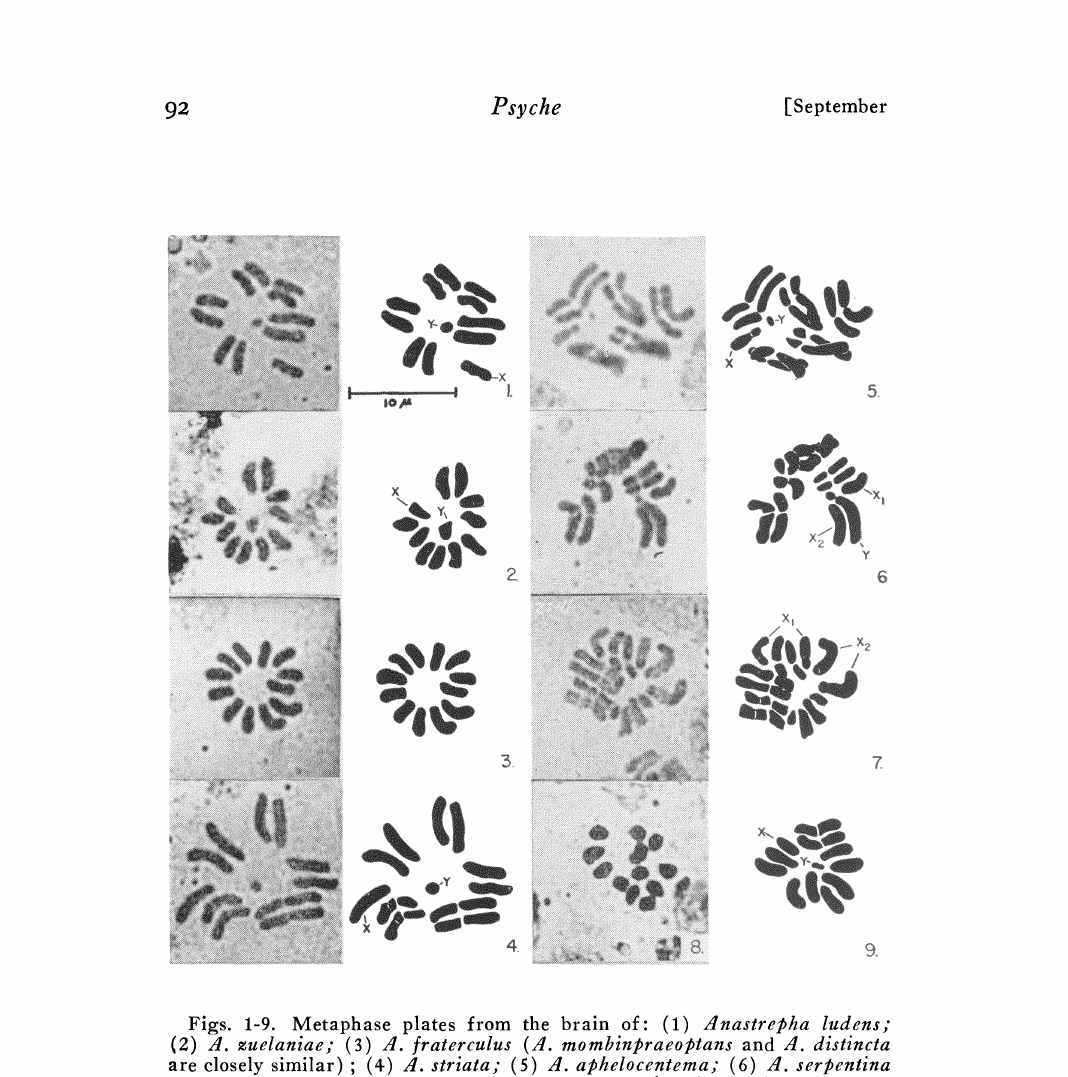
Figs. 1-9. Metaphase plates from the brain of" (1) dnastreIha ludens; (2) d. zuelaniae; (3) d. fraterculus (d. mombinpraeoltans and A. distincta are closely similar) (4) d. striata; (5) d. alhelocentema; (6) d. serlentina showing X1XY sex chromosomes; (7) d. serIentina showing X1XXX sex chromosomes. (8) Extreme contraction of chromosomes of d. ludens resulting from extended pre-treatment in eoumarin. (9) Spermatogonial metaphase plate from testes of adult d. slatulata. (Magnification of all plates